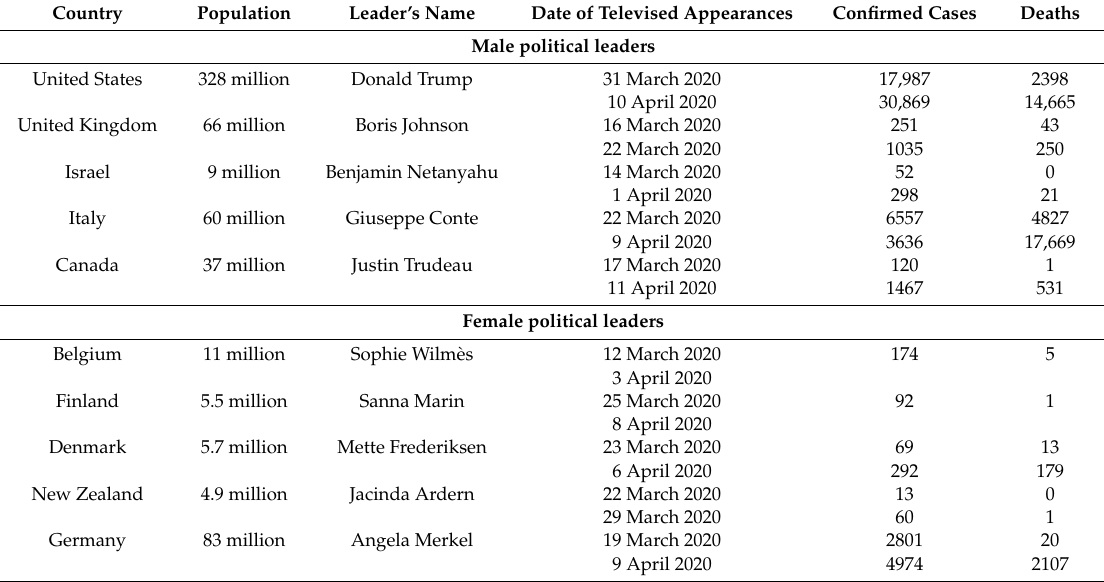
Table 2. Male / female political leaders’ televised appearances and the situation of the pandemic. Country